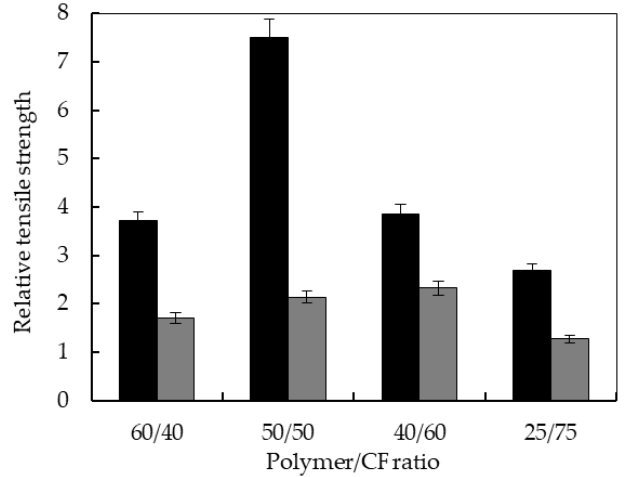
Figure 7. Relative tensile strength of TPUU-SS/CF (black) and TPUU/CF (gray) biocomposites.